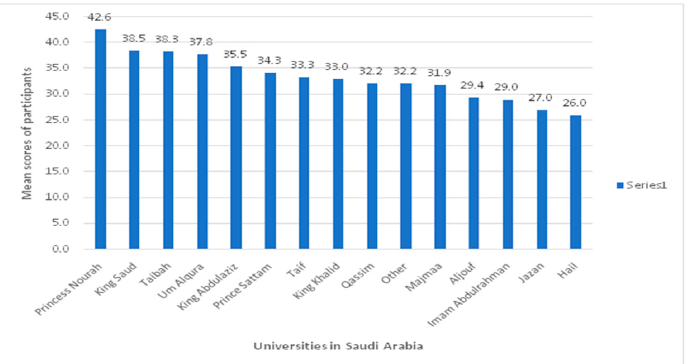
Figure 4. Mean scores of participants from different universities in Saudi Arabia.